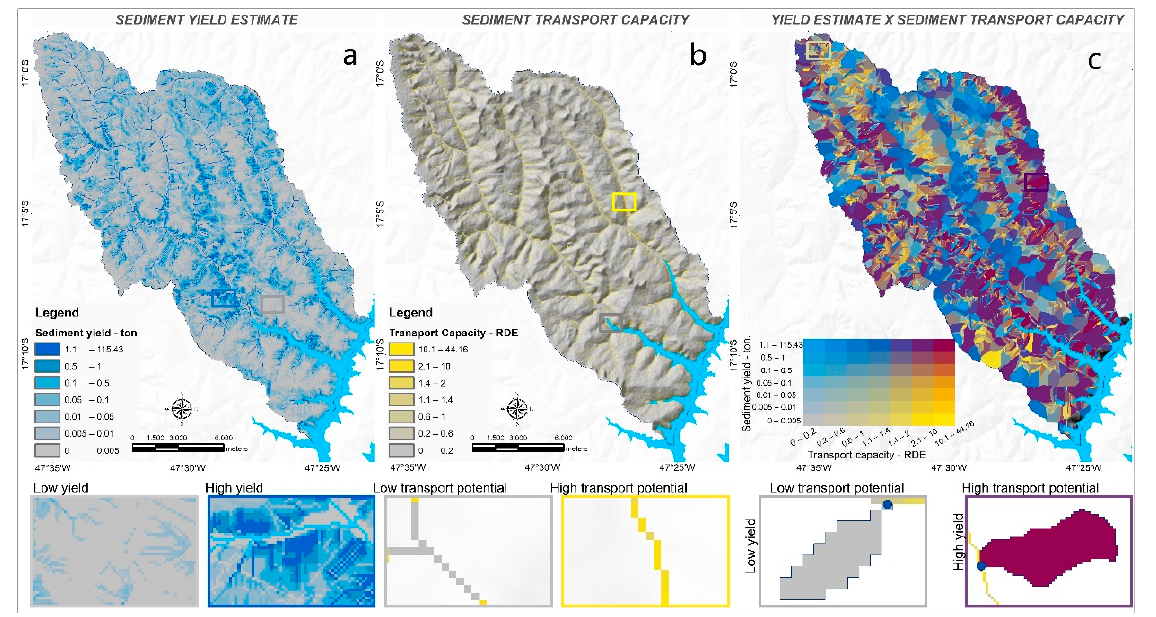
Figure 6. Distribution of the variable soil loss estimate (part a ); distribution of the variable sediment transfer capacity (part b ); and resulting from the combination of soil loss estimate × sediment transport capacity (part c ).